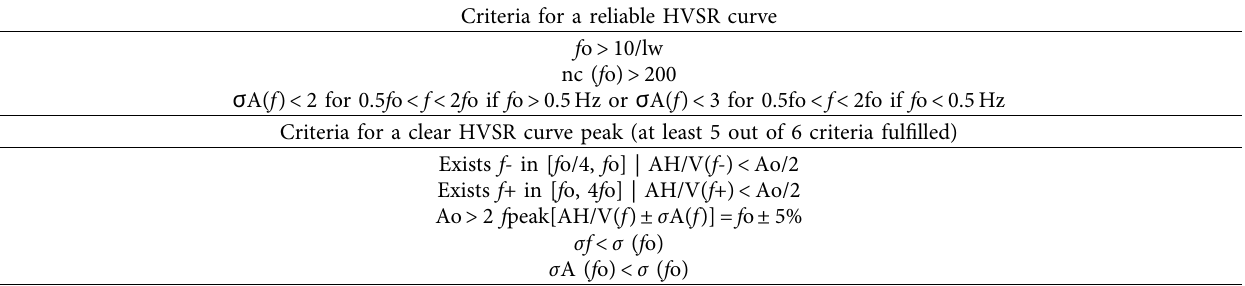
Table 1: SESAME criteria for HVSR data. Criteria for a reliable HVSR curve